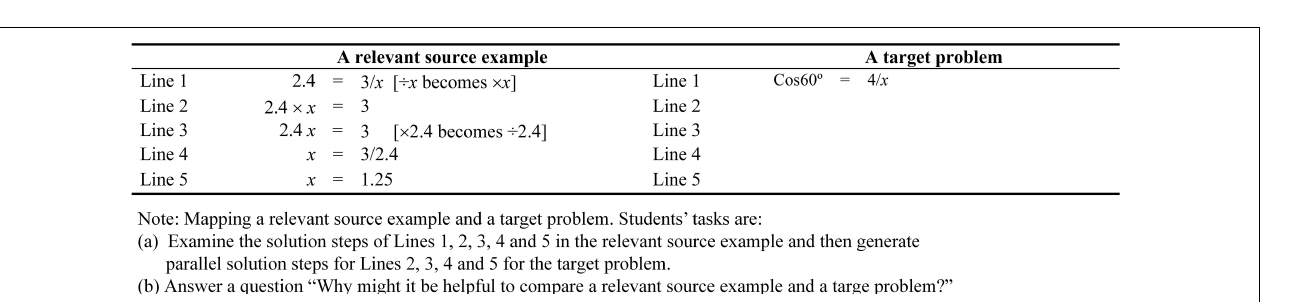
FIGURE 3 | Three variants of source examples.